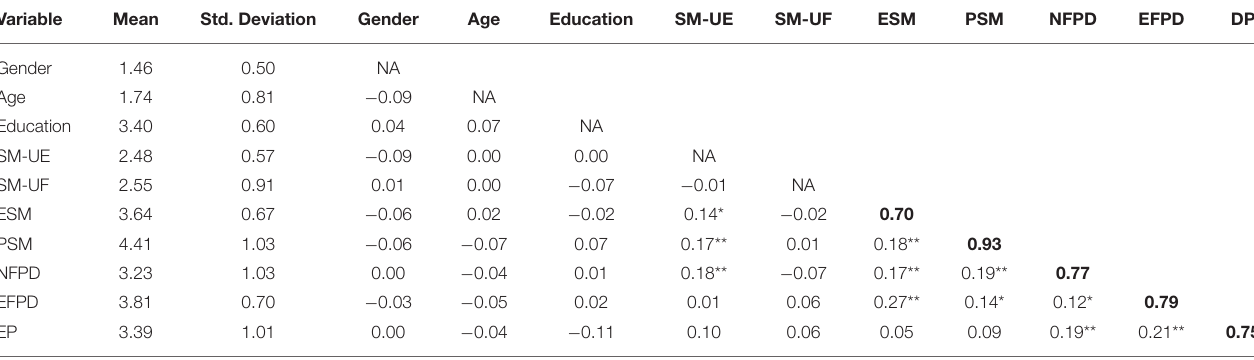
TABLE 3 | Discriminant validity.